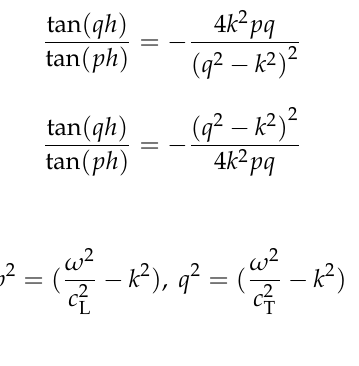
plate can be simplified into the LW frequency equation in symmetric and antisymmetric mode without consideration for in-plate stress, as shown in Equations (5) and